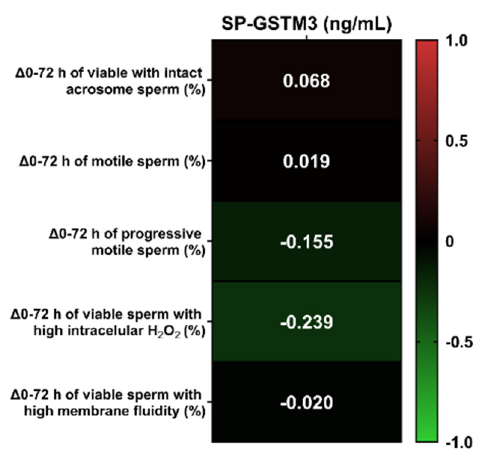
Figure 3. Heatmap of Pearson correlation coe ffi cients between seminal plasma GSTM3 (SP-GSTM3) concentrations (ng / mL) and the di ff erences of sperm quality and functionality parameters between 0 and 72 h of storage ( n = 20). No significant correlations were found ( p > 0.05).